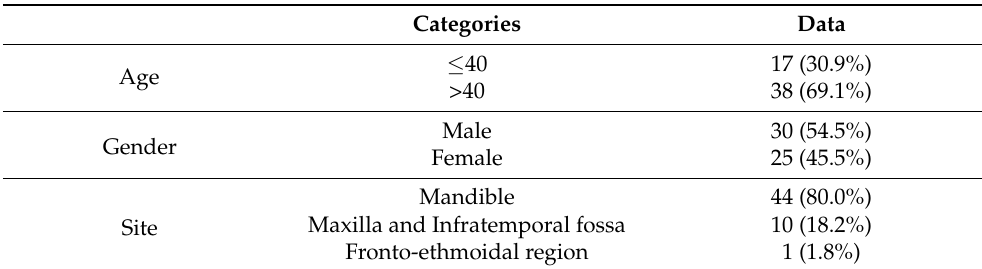
Table 1. Cohort characteristics.